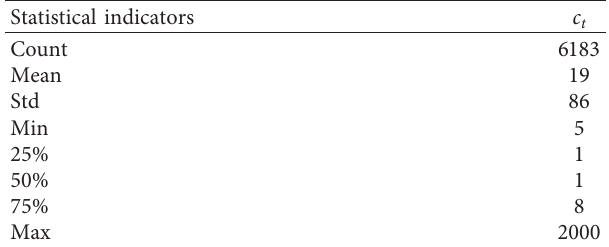
Table 2: News reading distribution statistics.